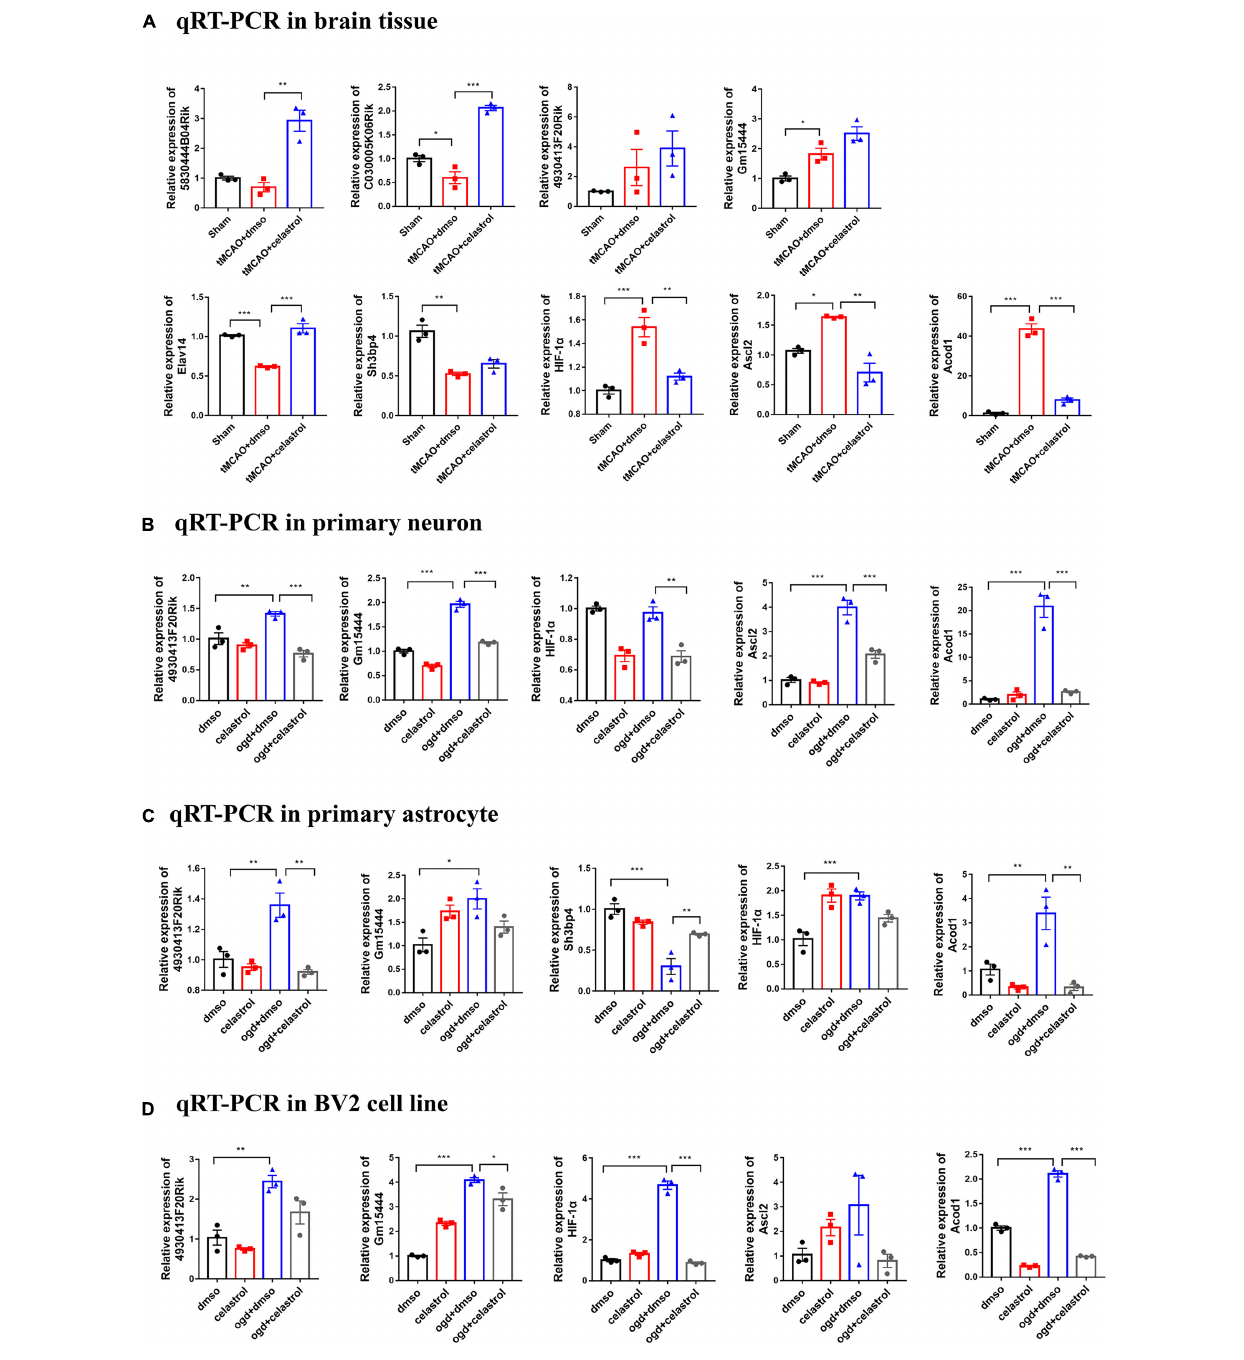
FIGURE 7 | Differentially expressed lncRNAs and mRNAs confirmation by qRT-PCR. (A) Validation of DE lncRNAs and DE mRNAs in brain tissue. (B) Validation of DE lncRNAs and DE mRNAs in primary neuron. (C) Validation of DE lncRNAs and DE mRNAs in primary astrocyte. (D) Validation of DE lncRNAs and DE mRNAs in BV2 cells. * P < 0.05, ** P < 0.01, *** P < 0.001, n =